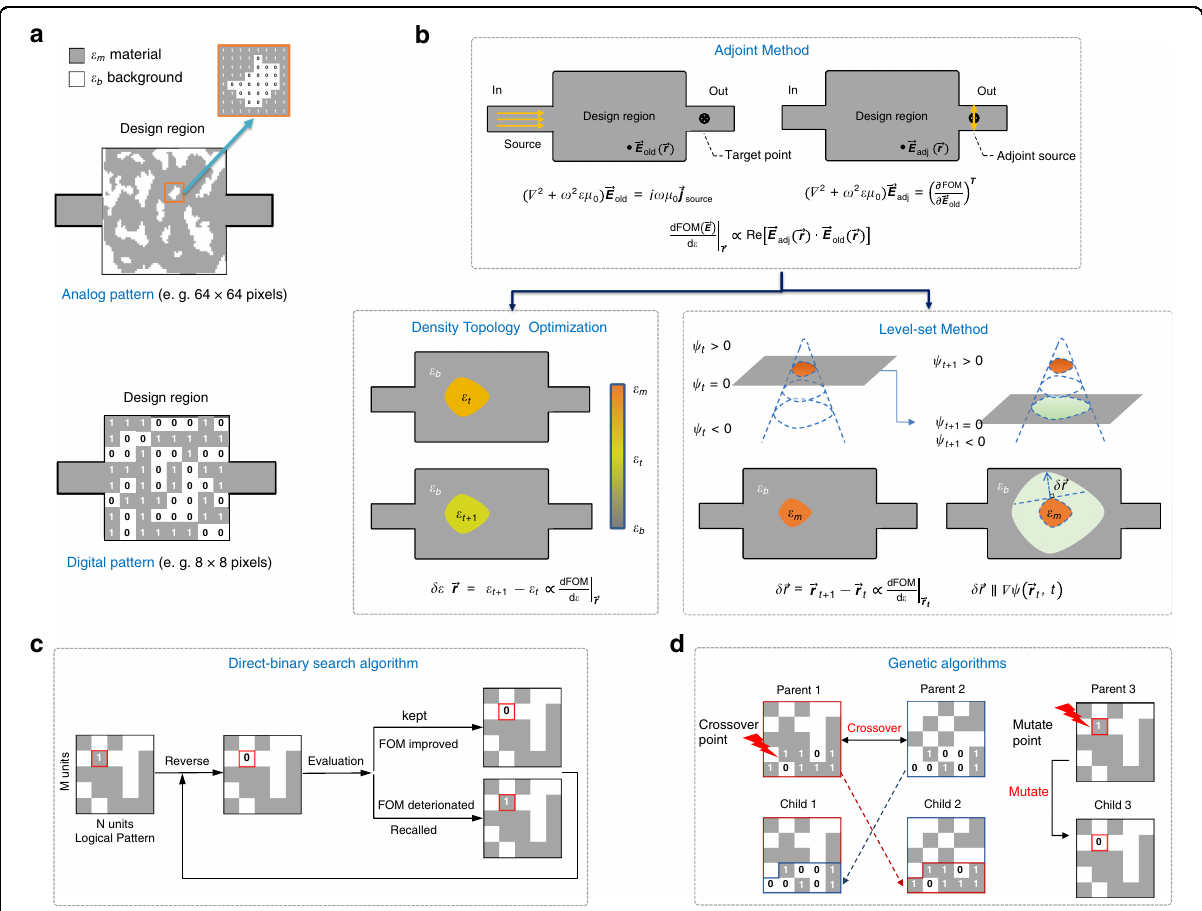
Fig. 10 Inverse-design tutorials for meta-waveguides. a Binary etching states for analog and digital meta-waveguide patterns. Pixel dimensions of an analog pattern are much smaller to produce curvilinear device boundaries. Digital patterns have relatively big regular-shaped (e.g. rectangular or circular) pixels 62 . b Adjoint method schematic: two simulations are needed for each iteration 15 , a forward simulation using the incident source as (cid:7) T as excitation source, where vector E old is the value of the electric fi eld at a given point before update. Sources for each simulation are marked in yellow. For level-set method, each point vector r on the boundary moves along its normal direction with a speed equivalent to the gradient value at this point. c Illustration of the iterative procedure in DBS algorithm. d The crossover and mutate mechanisms in a GA for reproducing new